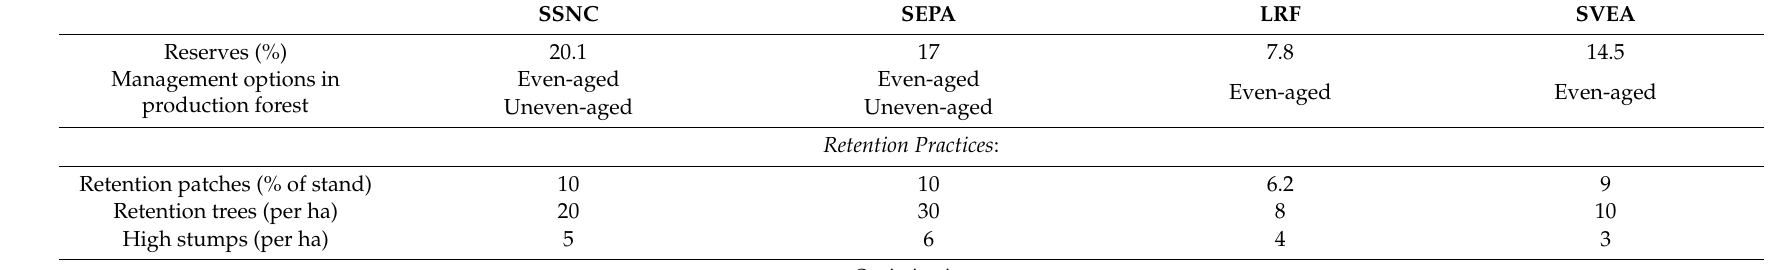
Table 1. Properties of the four stakeholder scenarios simulated. For details on management scenario settings, see Appendix